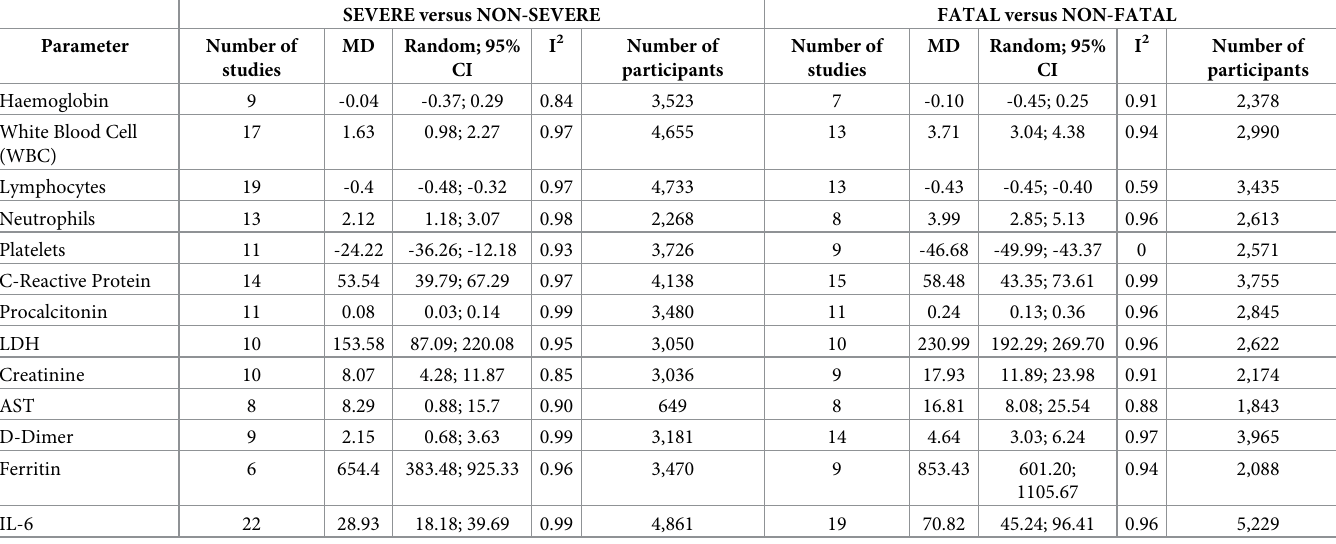
Table 3. Results of meta-analysis comparing laboratory parameters in COVID-19